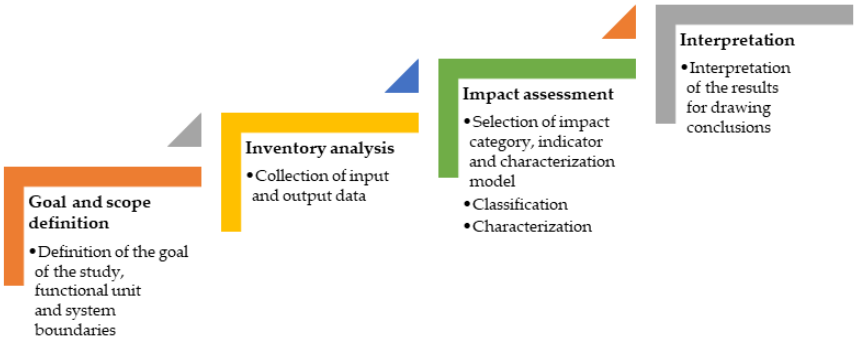
Figure 3. Four phases of life-cycle assessment in the study.